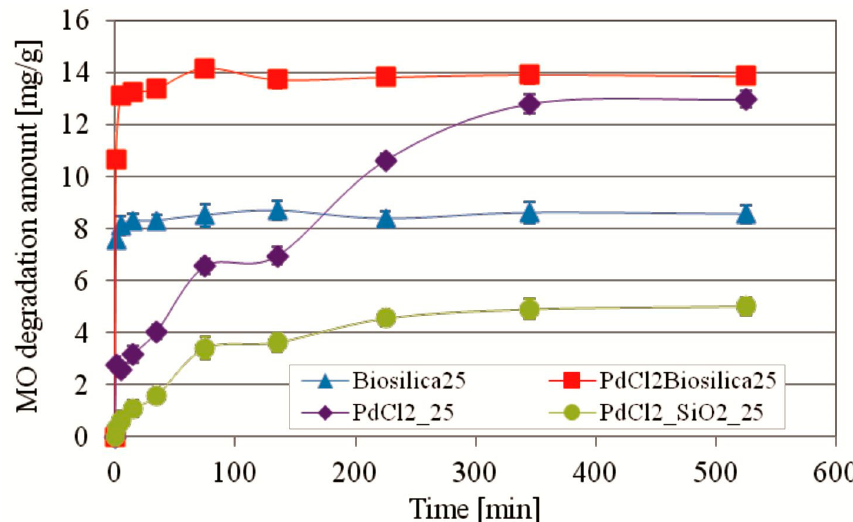
Figure 6. The comparison of the kinetics curves of MO photocatalytic degradation using PdCl2 biosilica and biosilica photocatalysts with the kinetics curves of MO photocatalytic degradation by pure PdCl2 and commercial amorphous silica doped with PdCl2. Experimental conditions: m (biosilica)—10 mg; T = 25 °C; C 0 (MO)—10.25 mg/L; V (MO solution)—15 mL; pH–7.0.